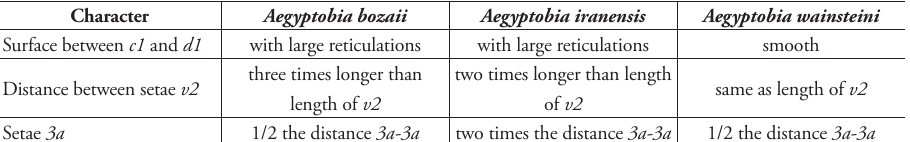
Table 2. Distinguishing characteristics among Aegyptobia bozaii, A. iranensis and A. wainsteini. Character Surface between c1 and